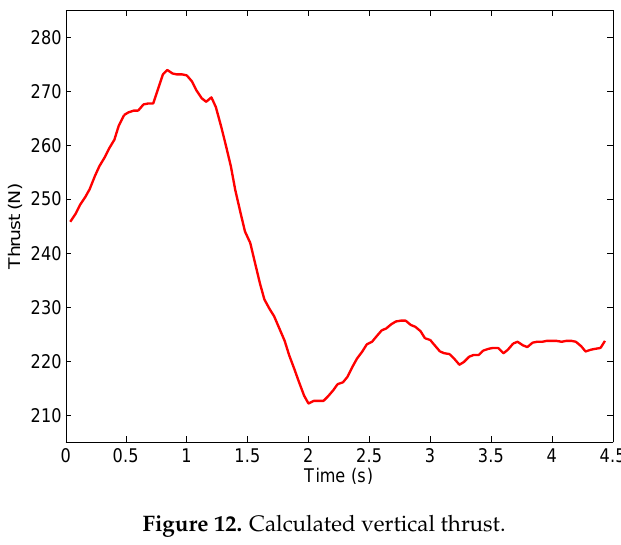
Figure 12. Calculated vertical thrust.